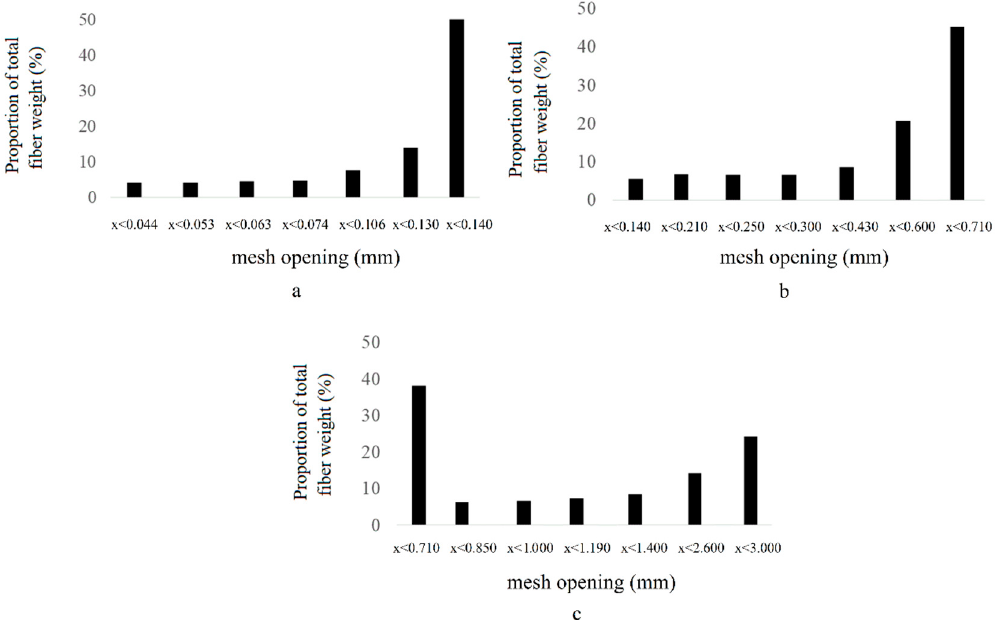
Figure 1. Fiber size distribution of white spruce according to the mesh opening [19]: ( a ) Fine fiber size, ( b ) Medium fiber size, ( c ) Coarse fiber